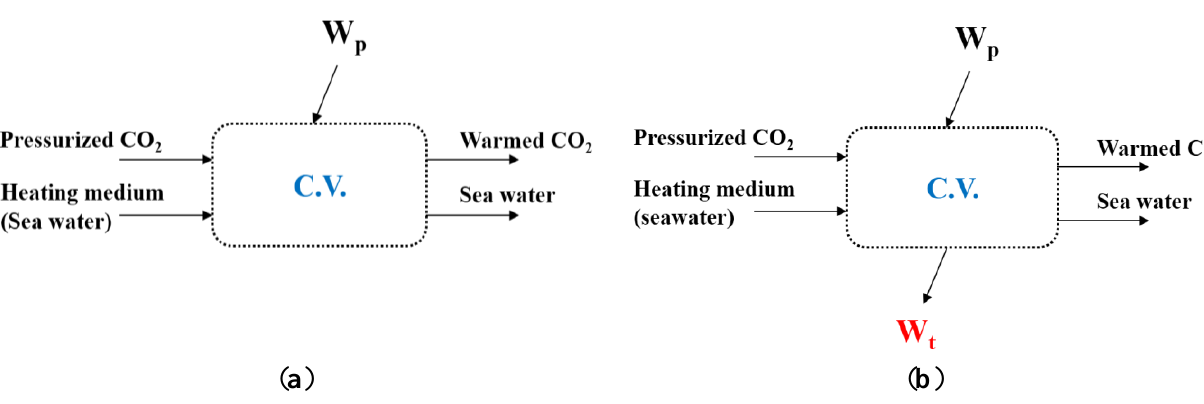
Figure 4. Control volume of each system. ( a ) System 1; ( b ) System